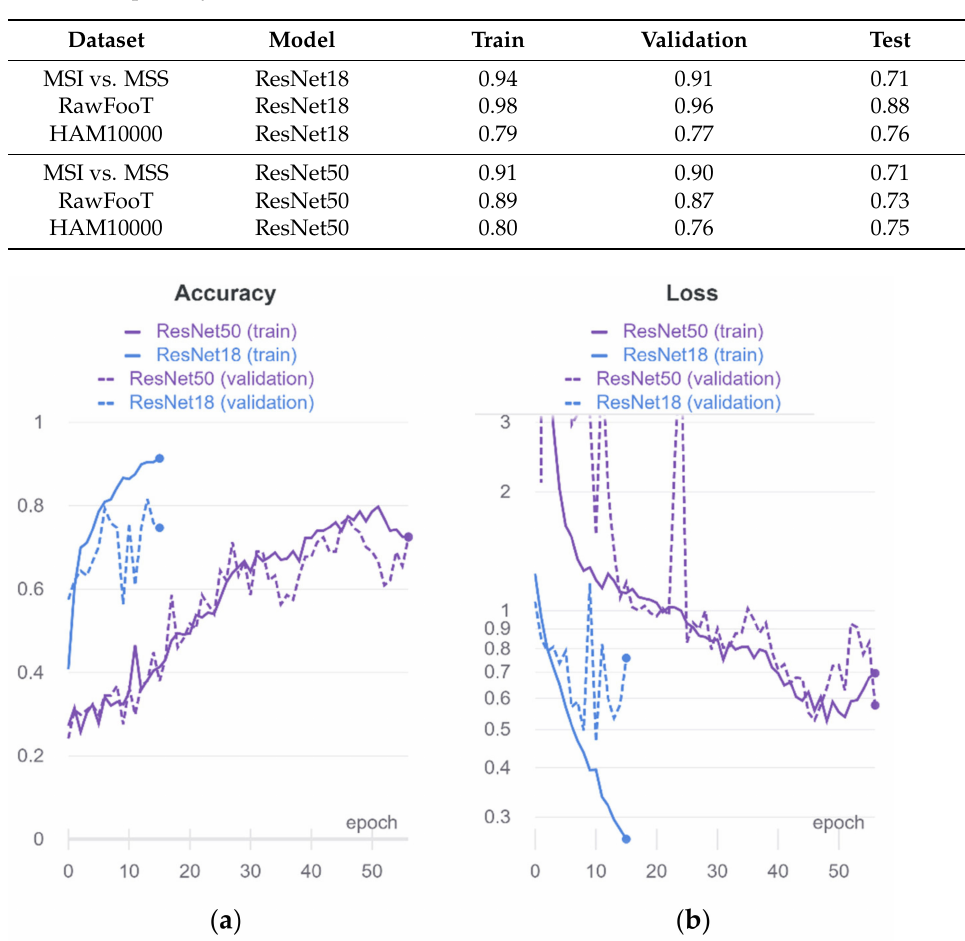
Table 5. Accuracy of the best performing models for the classification of each one of the datasets used for the primary task.